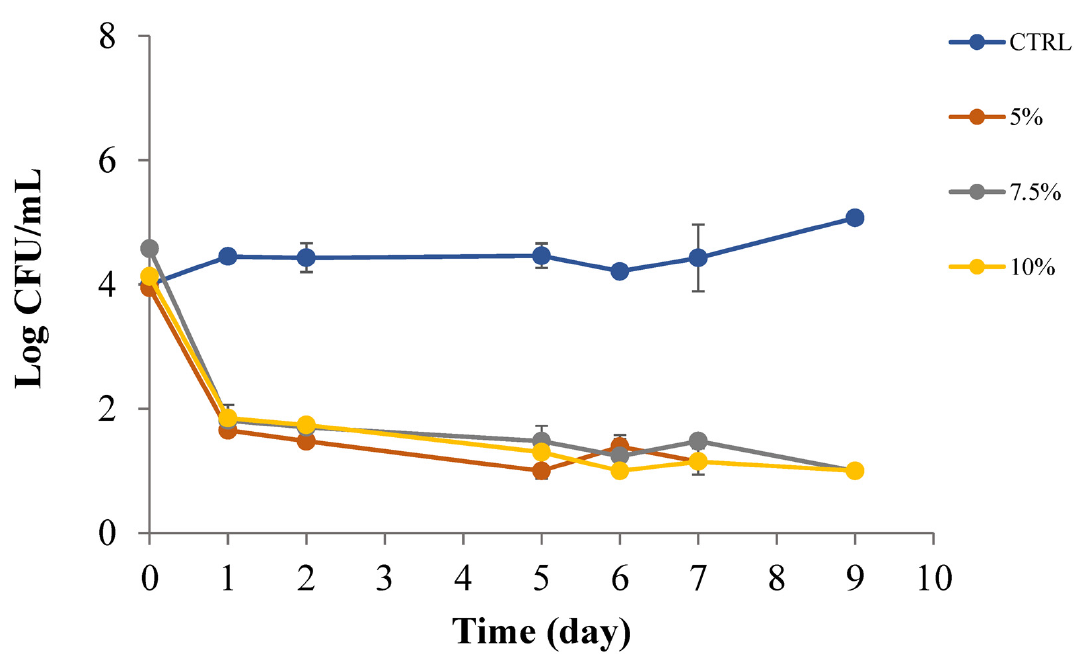
Figure 5. A. acidoterrestris in apple juice with PPP at 0, 5, 7.5 and 10% ( w / v ).